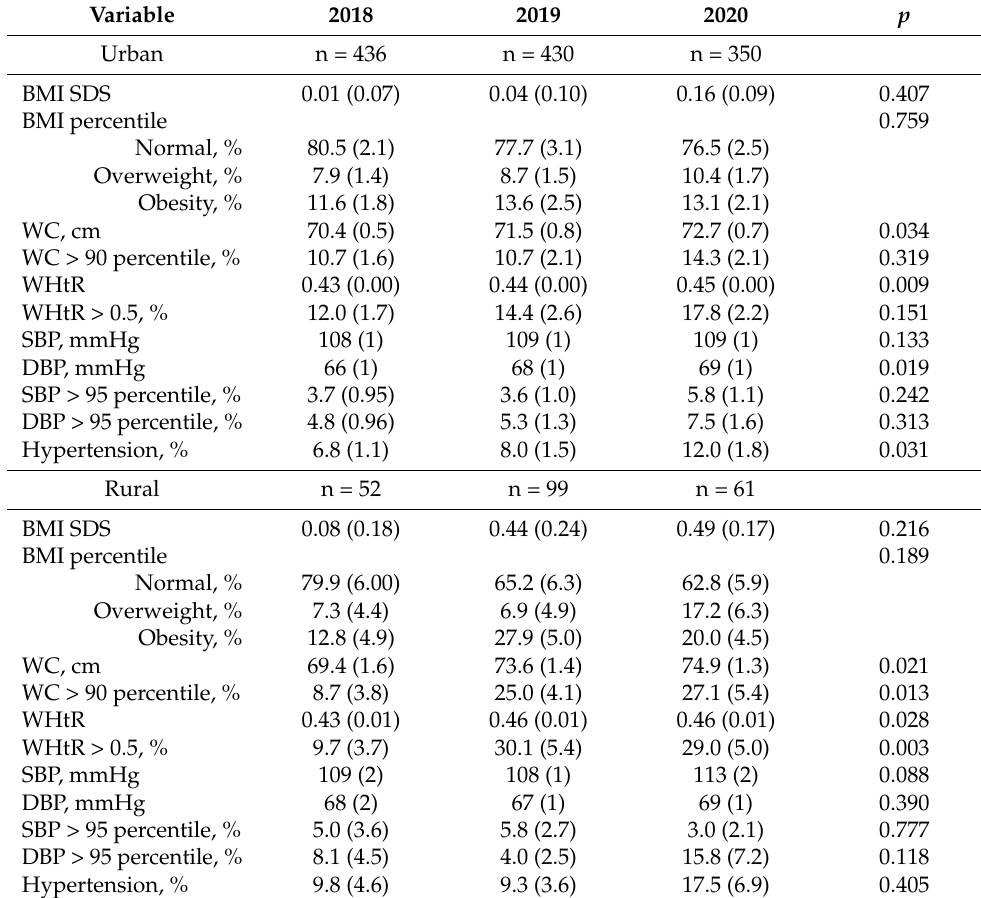
Table 5. Proportion of participants with obesity, abdominal obesity, and hypertension according to residential